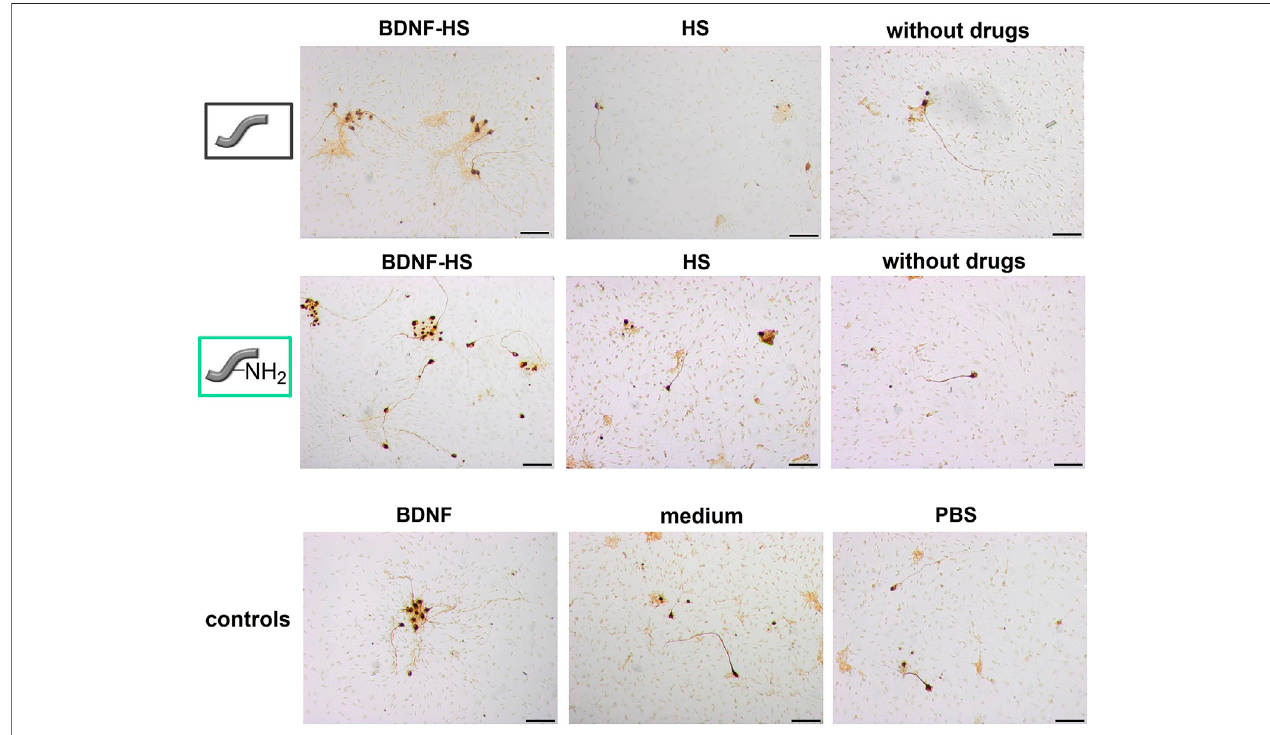
FIGURE 12 | Representative microscopic images of spiral ganglion cell cultures using the supernatants from the two different fi ber types, derived from the release experiment ofday 1. SGNs are counted assurvived neurons when a neurite with a length of at least three soma sizes has grown out ofthe cell soma. Scale bar 100 µm.